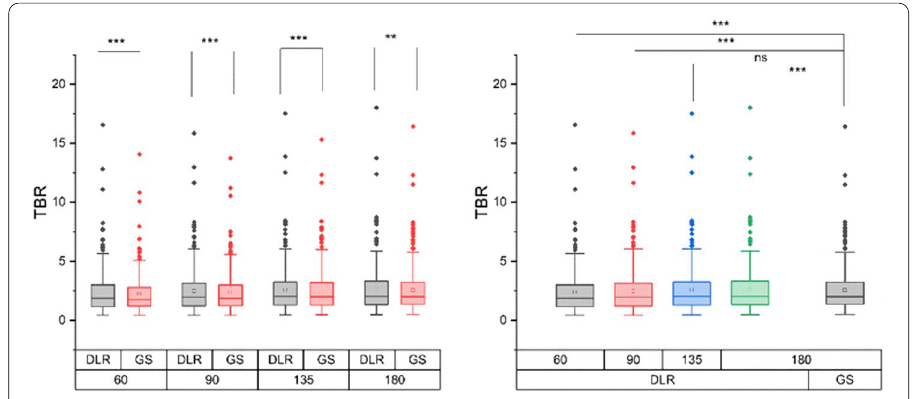
Fig. 10 Comparison of the lesion TBR between GS and DLR groups. Left: The HYPER DLR algorithm can improve the lesion contrast significantly compared to that achieved by GS approach with the same acquisition duration. Right: Compared with the reference GS_180 group, the DLR_135 group shows no significant difference in TBR, indicating a similar lesion contrast. ** p < 0.01; *** p < 0.001; ns, no significant difference. TBR, target-to-background